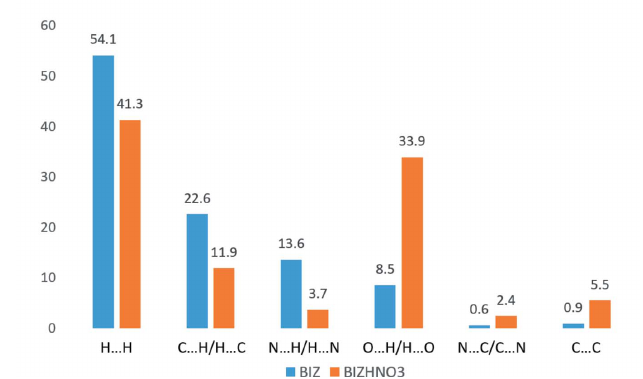
Figure 7 Relative contributions of the strongest intermolecular interactions (in %) to the total Hirshfeld surface of the neutral molecule and its cation in the structures of BIZ and BIZHNO3.